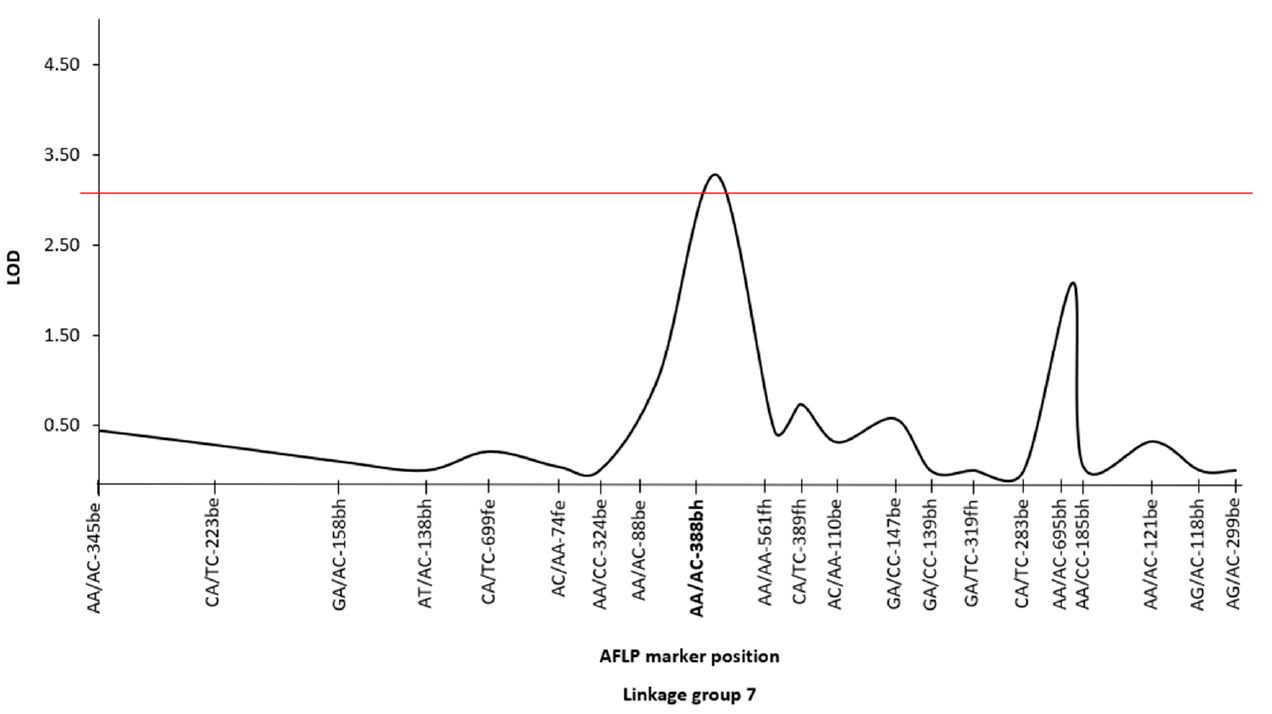
Figure 2 . QTL was detected using MapQTL 6 [54] for the growth of F. circinatum FSP34 on a pine- based medium. The identified QTL ( p = 0.05, indicated by the red line) was located in linkage group 7 (chromosome 11), with the nearest AFLP marker AA/AC-388bh being 4.5 cM away [26].